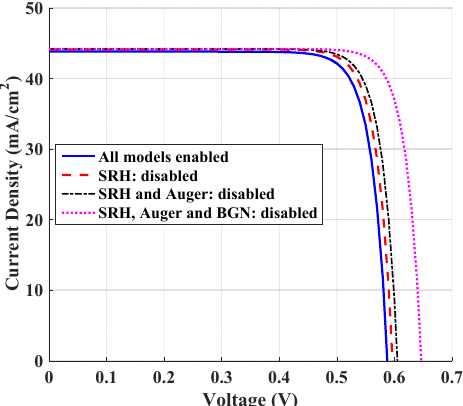
Figure 8. Recombination rate along the lateral distance of the flipped npn structure for different values of base lifetime.